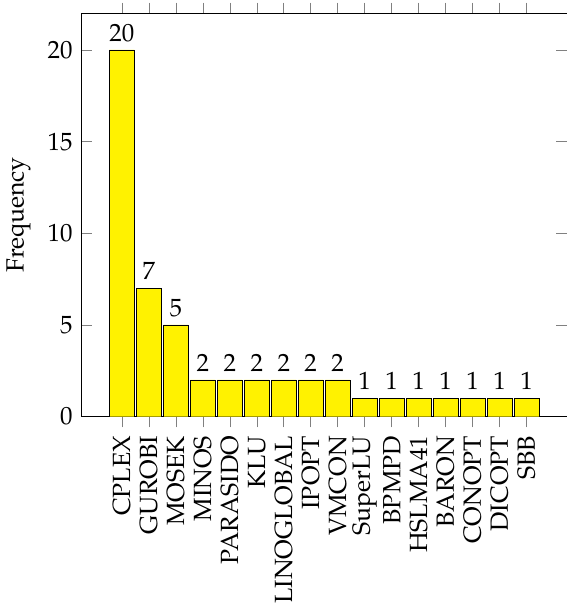
Figure 15. The occurrences of solvers in the reviewed